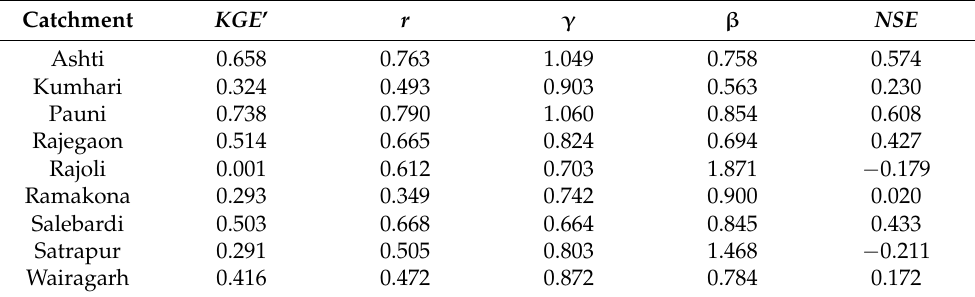
Table 5. Performance metrics (lumped sub-catchment modeling, single parameter set).